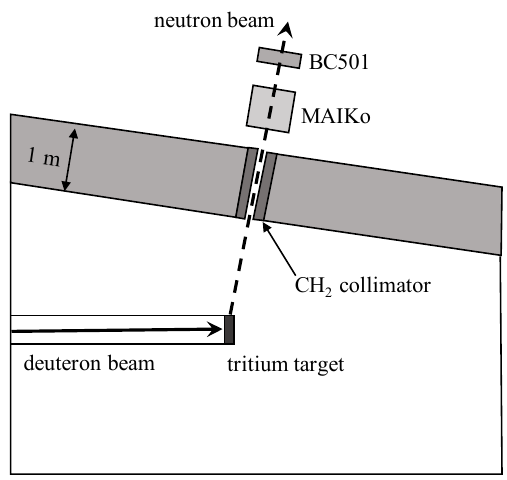
Figure 1. Experimental setup at OKTAVIAN.